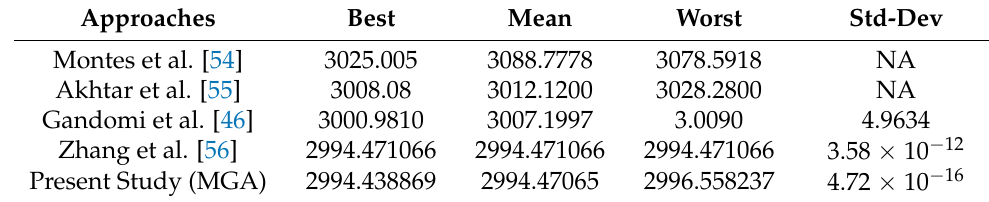
Table 8. Statistical results of different approaches for the speed reducer design problem.